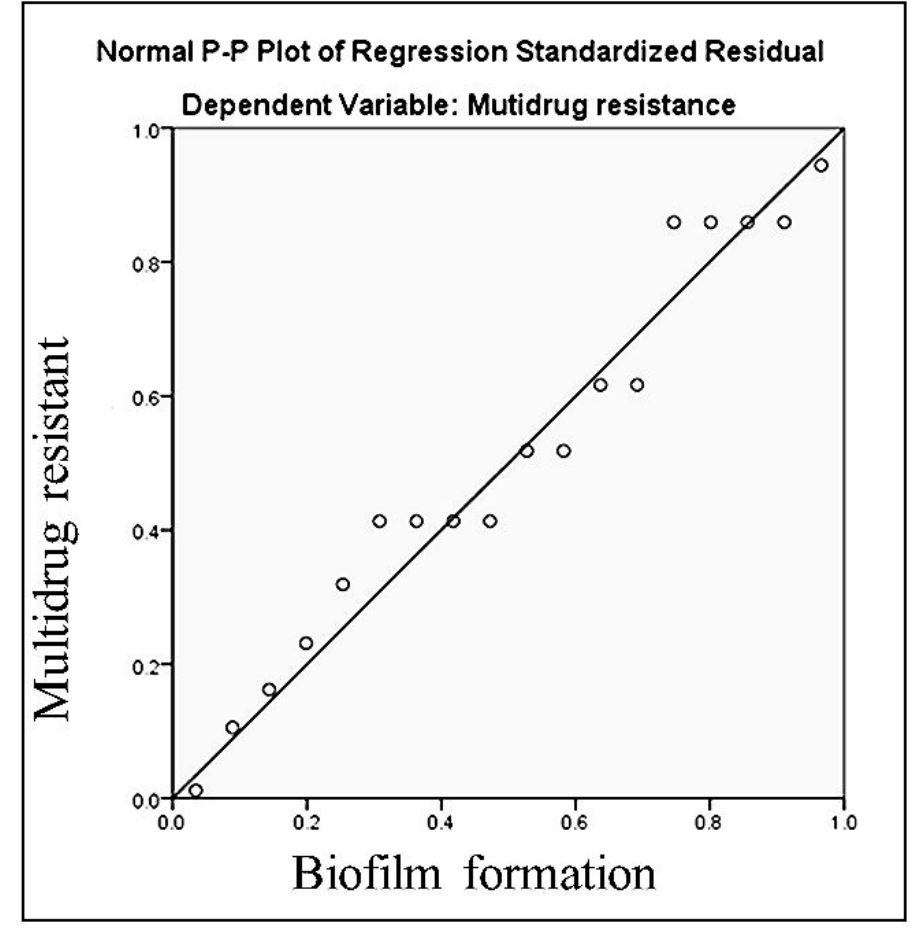
Figure 4. The relation between multidrug resistance and biofilm formation in Pseudomonas spp.